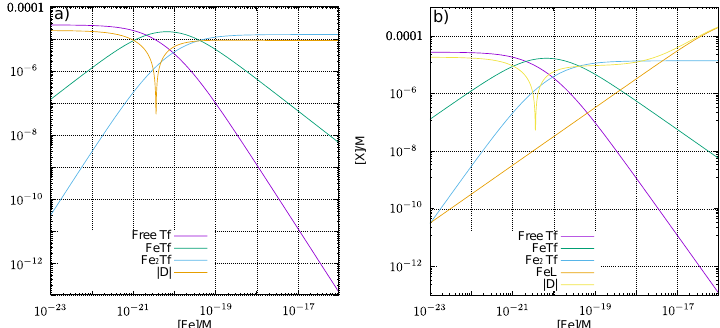
Figure 4. The dependence of each coordination species on the free iron concentration, [Fe]. The vertical line shows the log of each iron species, whereas the horizontal one shows the log of [Fe]. D is the difference in total iron from the sum of the iron of each species including free iron. The minimum | D | indicates the actual equilibrium of each iron coordination compound. ( a ) without point of log 10 ligand; ( b ) with ligand, L.